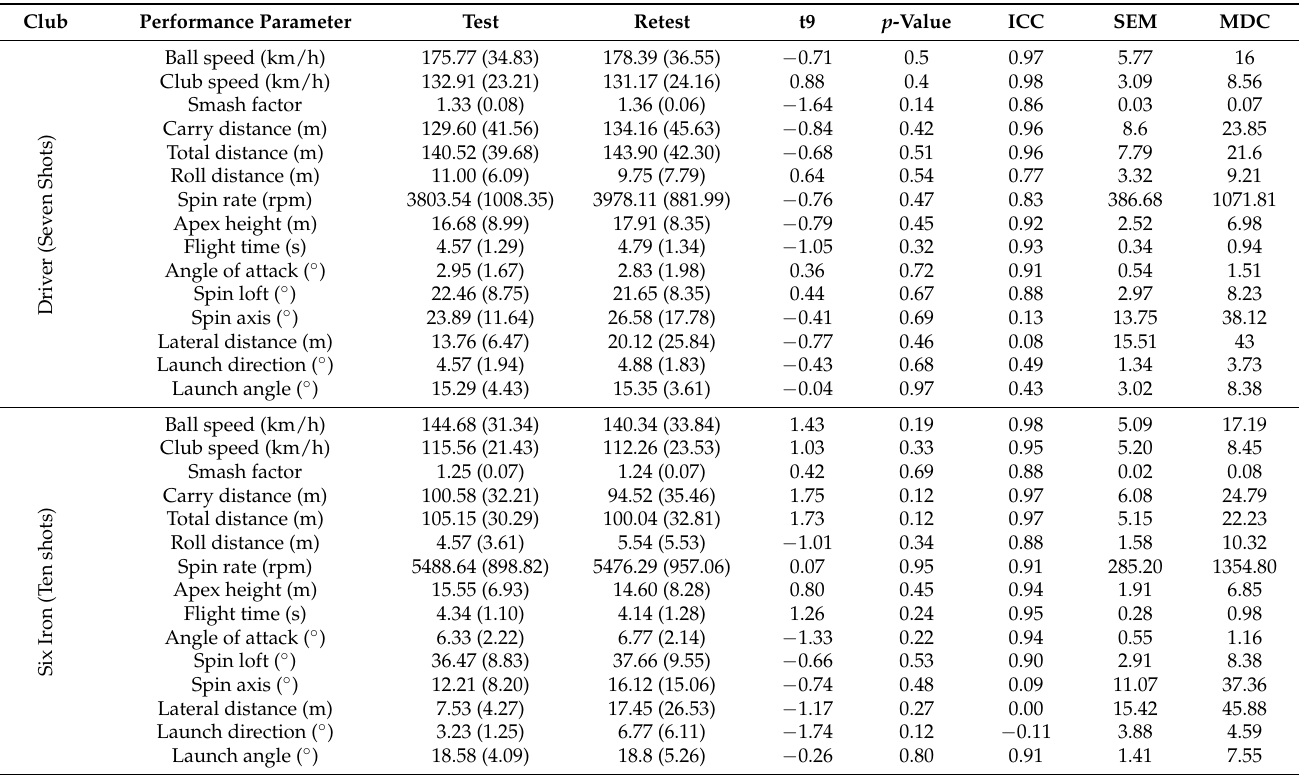
Table 4. Mean, standard deviation and reliability values of the performance parameters using the required number of trials for the